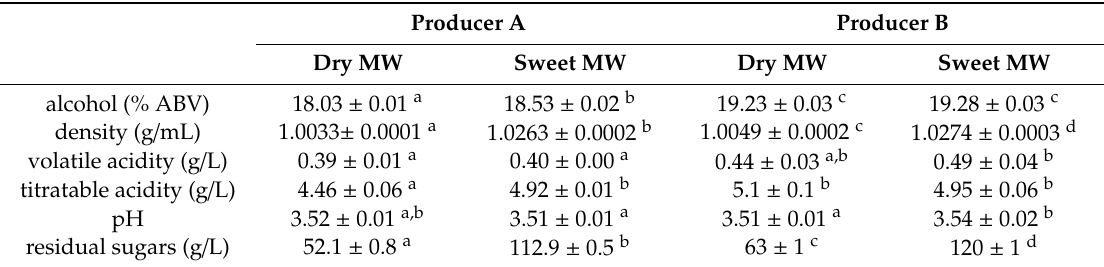
Table 1. Oenological parameters of commercial 3-year-old Madeira wines (MWs) selected for the sotolon sensory